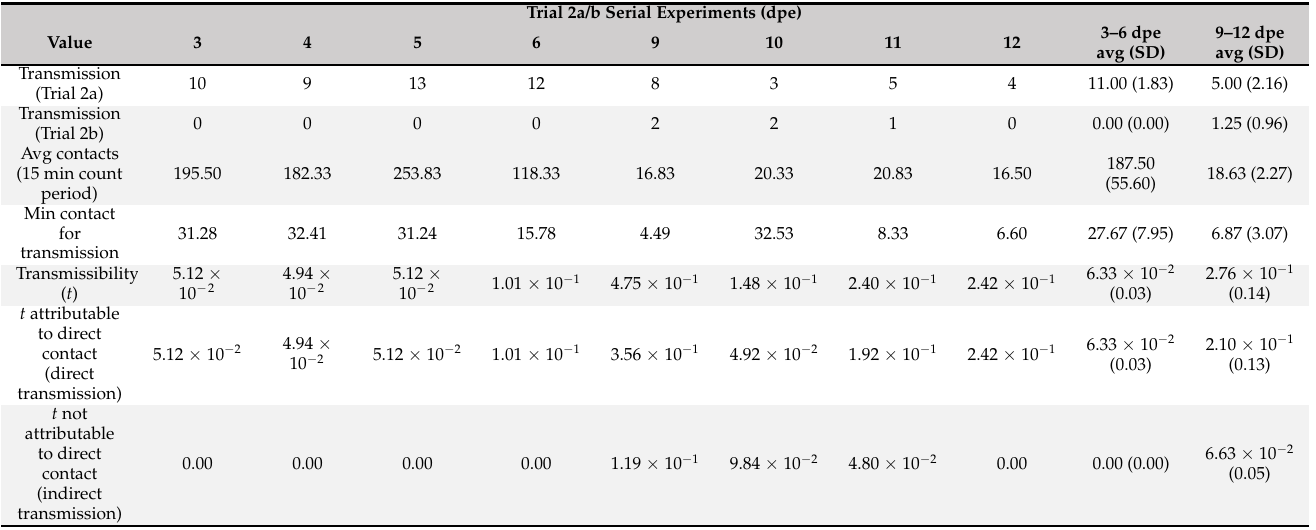
Table 4. Transmission, contact rate and transmissibility CyHV-3 attributable to direct and indirect